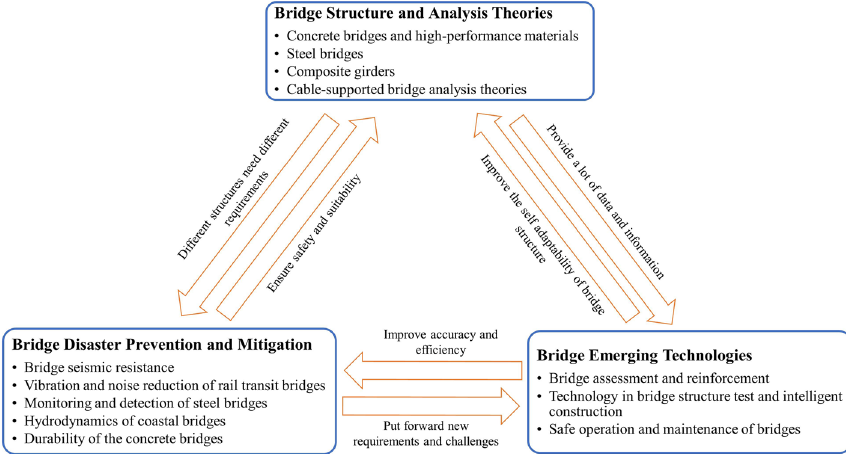
Fig. 1 The manuscript logic structure block